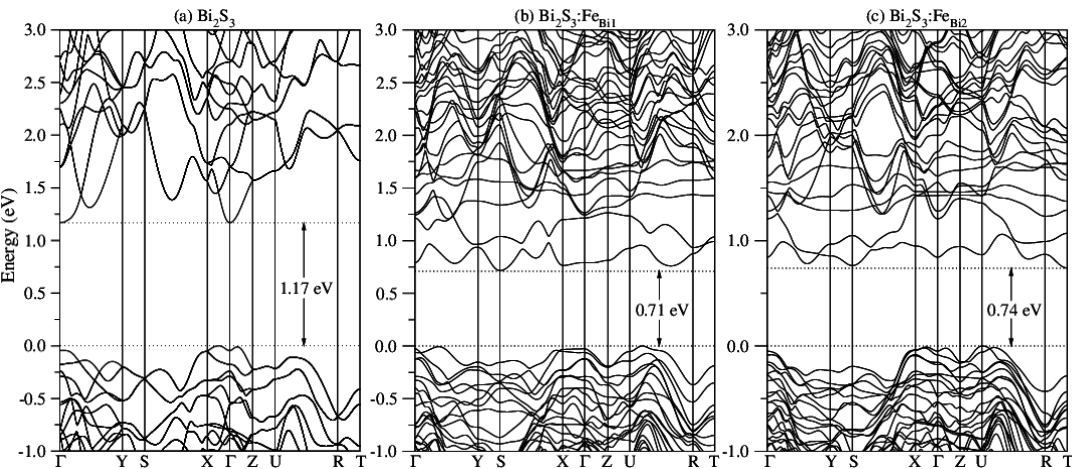
Figure 5. First-principle band structures for ( a ) bulk Bi 2 S 3 , ( b ) Fe-doped Bi 2 S 3 at Bi1 site, and ( c ) Fe-doped Bi 2 S 3 at Bi2 site. Horizontal dashed lines indicate valence bands maximum (set to zero) and conduction bands minimum. The selected k points are Γ =(0,0,0), Y=(0,½,0), S=(½,½,0), X=(½,0,0), Z=(0,0, ½), U=(½,0,½), R=( ½, ½, ½), and T=(0,½,½).